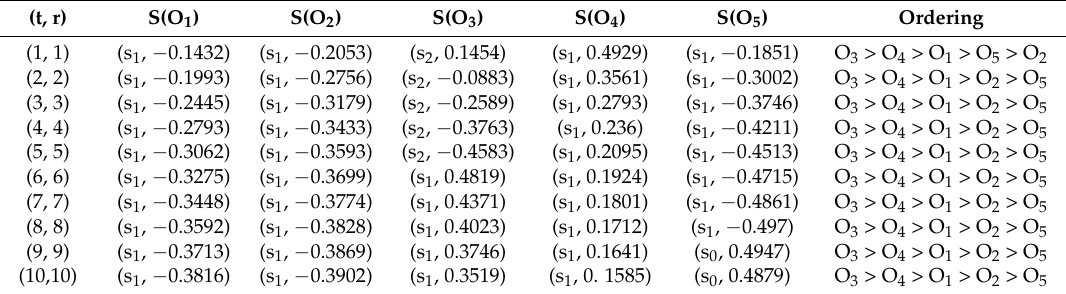
Table 6. Ranking results for different operational parameters of the P2TLWGBM operator.